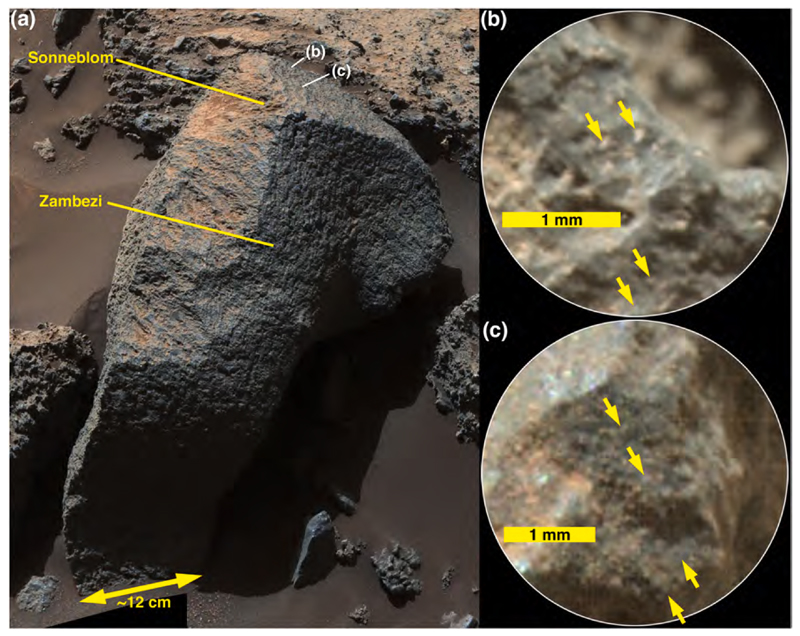
(a) Boulder containing targets Sonneblom (ChemCam, APXS, MAHLI) and Zambezi (APXS, MAHLI). The boulder is a dark-gray, pitted sandstone; the locations of the MAHLI views in (b) and (c) are indicated. (b and c) Close-up views of the surface; the arrows point to several individual grains.